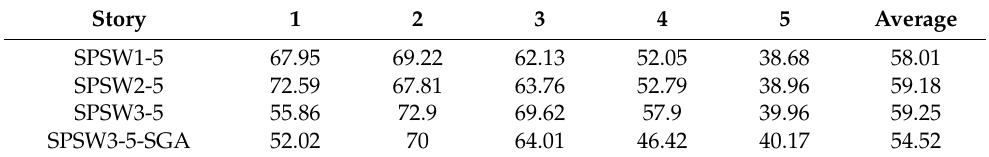
Table 6. Percentage of story shear resisted by steel plate in the optimum designs of 5-story steel frame